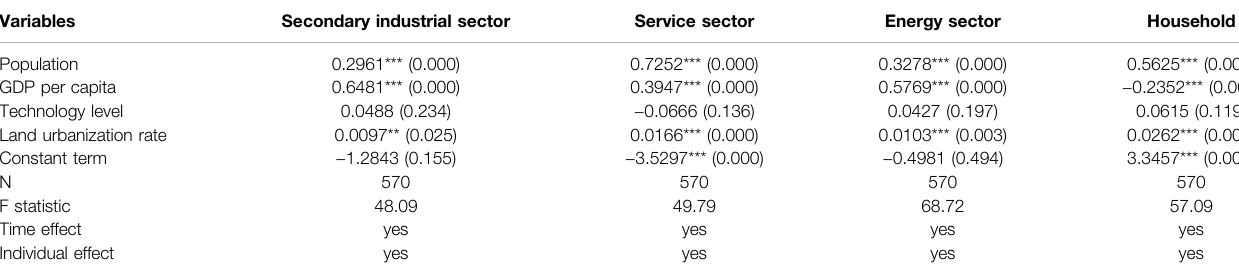
TABLE 4 | Estimating results between land urbanization and sectoral CO 2 emissions. Variables